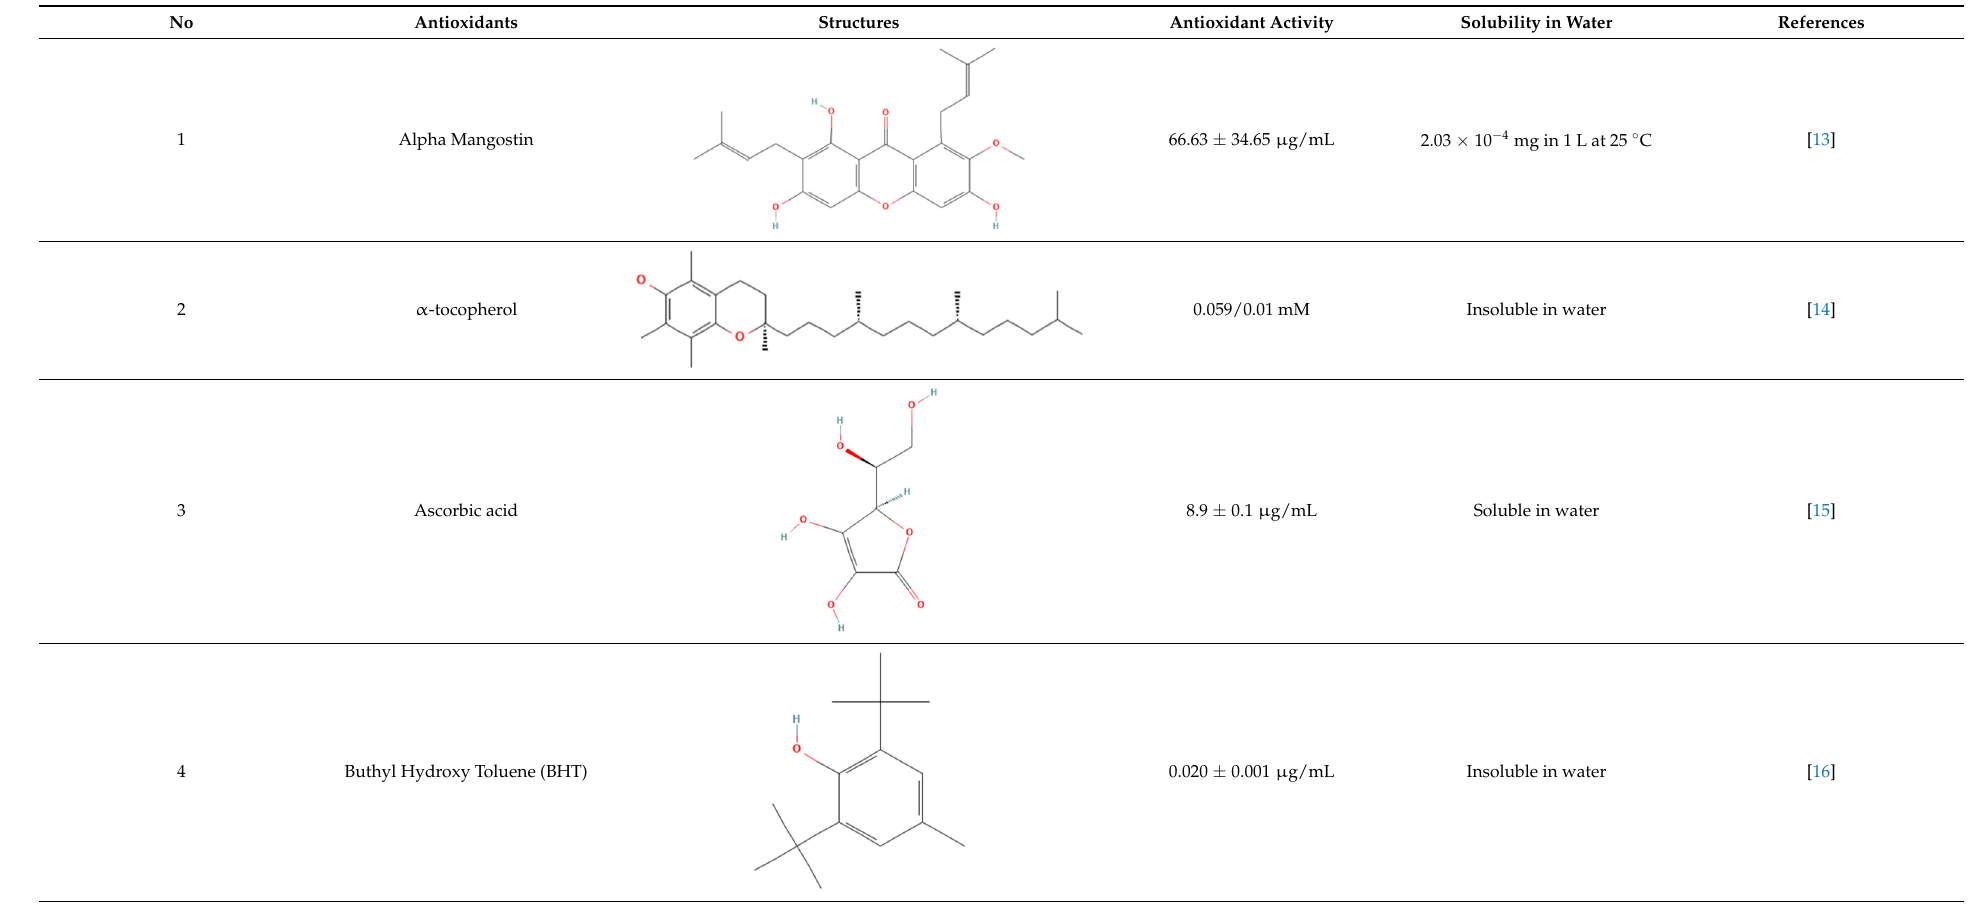
Table 1. Common Active Pharmaceutical Antioxidant Compounds.